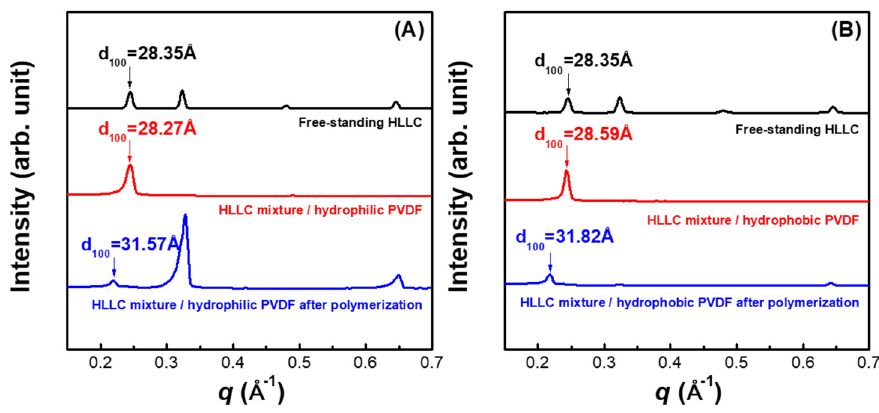
Figure 3. XRD profiles of TFC with ( A ) hydrophilic and ( B ) hydrophobic PVDF. Table 1. Dimensional evolution of structure for d 100 (a) before and (b) after polymerization and column diameter (c) before and (d) after polymerization.